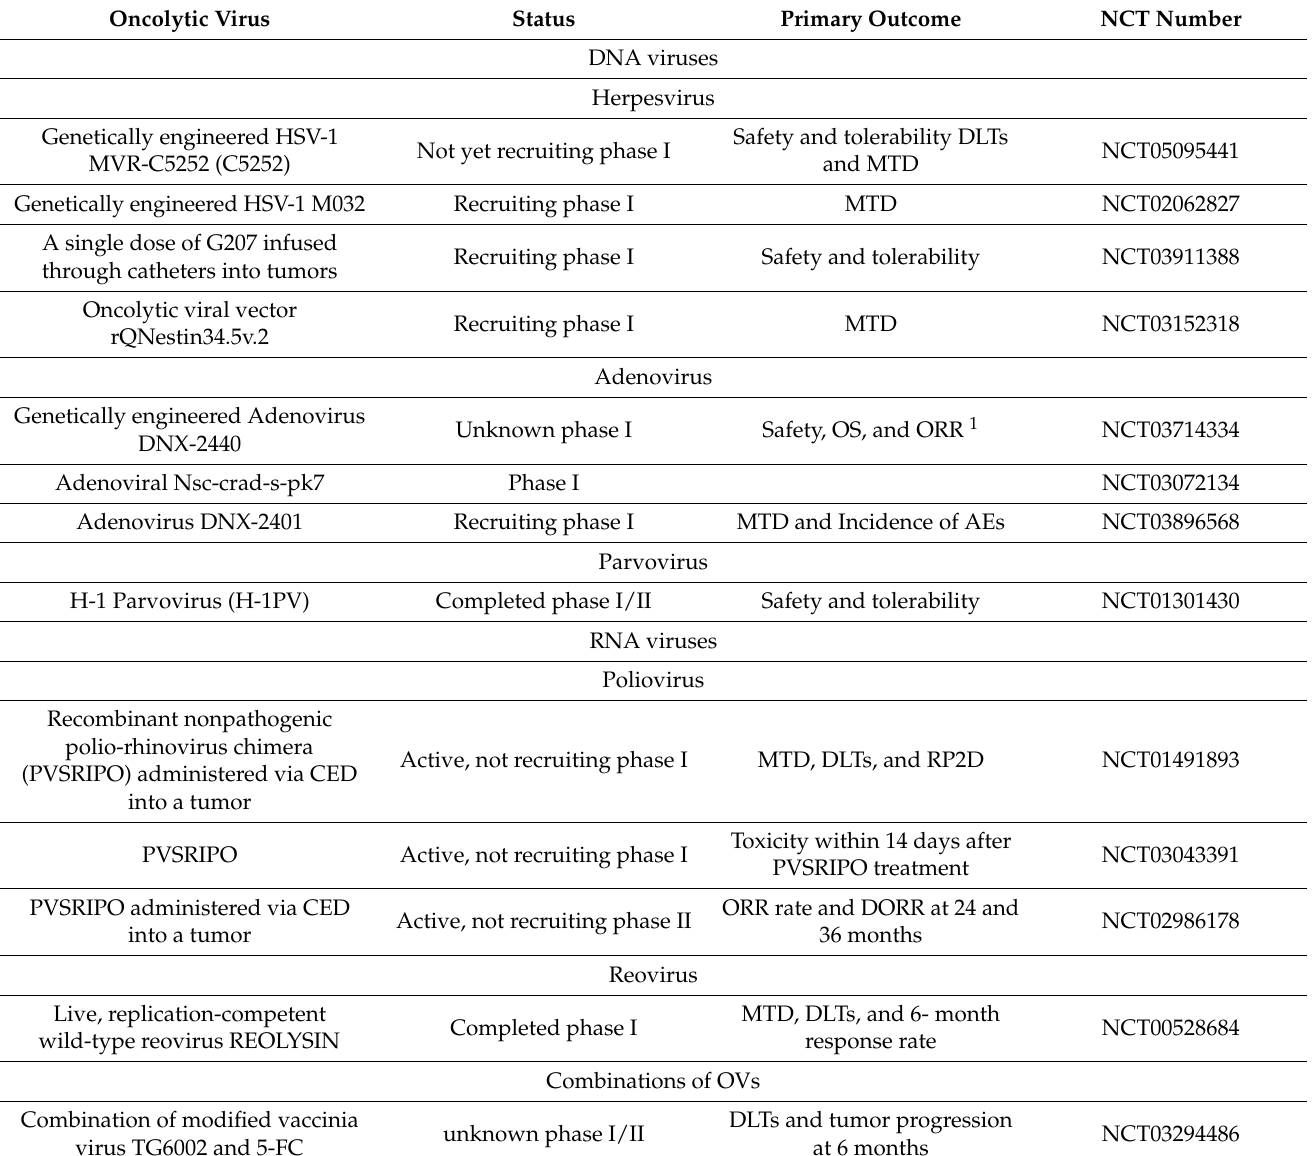
Table 1. Complete oncolytic viruses in clinical trials for GB